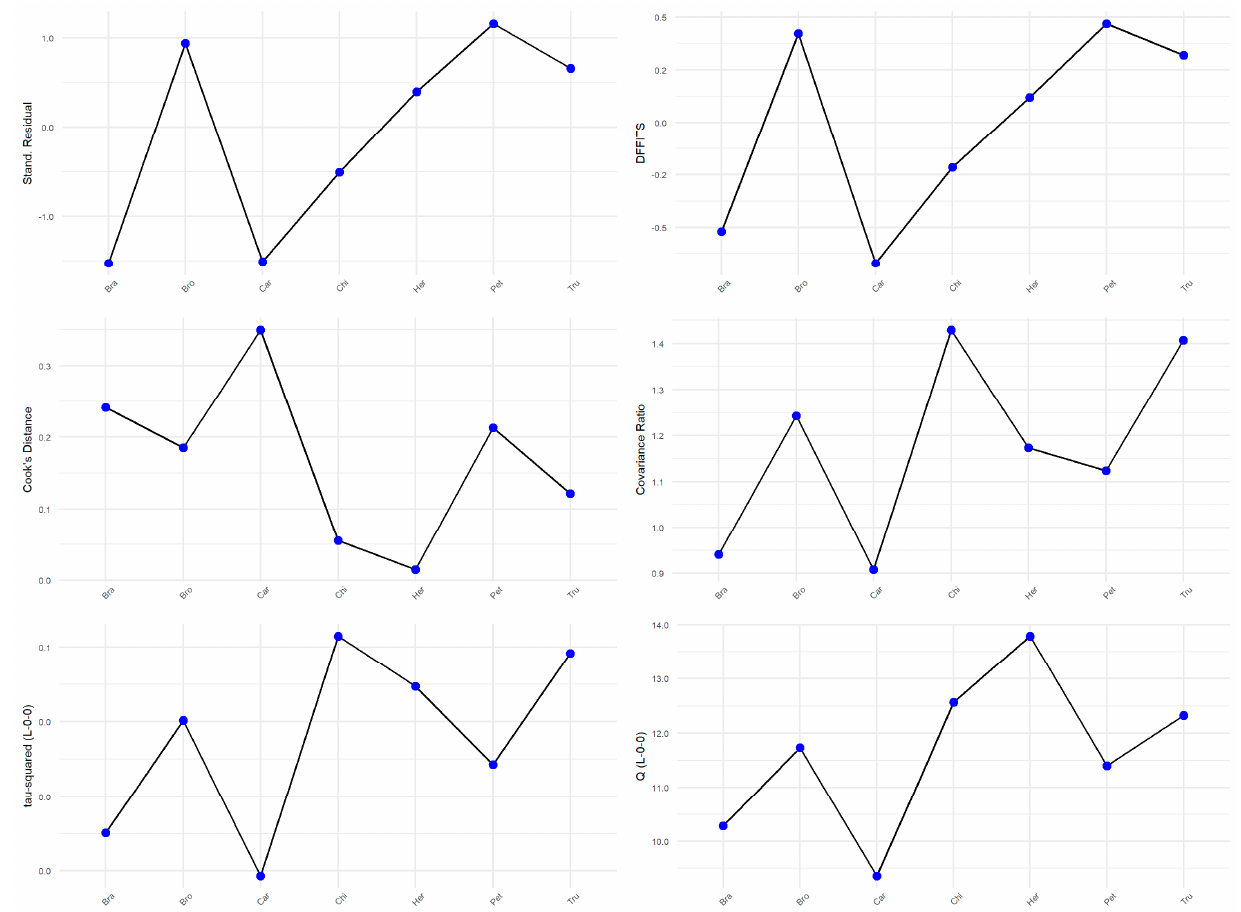
Leave-one-out figure of all the studies for the Helplessness score